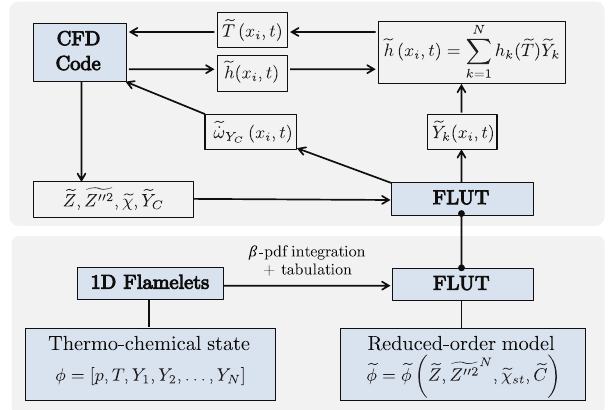
Fig. 1. Coupling scheme of the UFPV-LES approach for spray combustion.